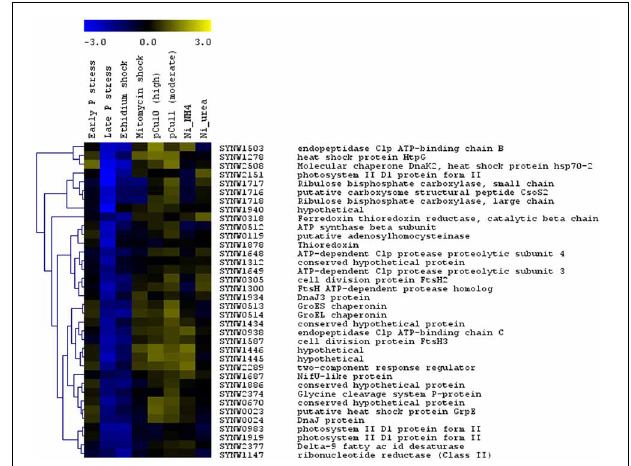
FIGURE 2 | Hierarchical trees showing clusters of Synechococcus sp. WH8102 genes whose expression was affected similarly by growth under a large number of stress conditions. The expression levels for this strain under eight different stress conditions: early and late phosphate stress (Tetu et al., 2009), EB and MC shock (this study), moderate and high copper shock (pCu11; pCU10) (Stuart et al., 2009) and Nickel (Ni) deprivation in cultures growing on NH4 + and urea (Dupont et al., 2012) were compared. For each set of experiments data from two independent biological replicates was used. The color bar indicates the log 2